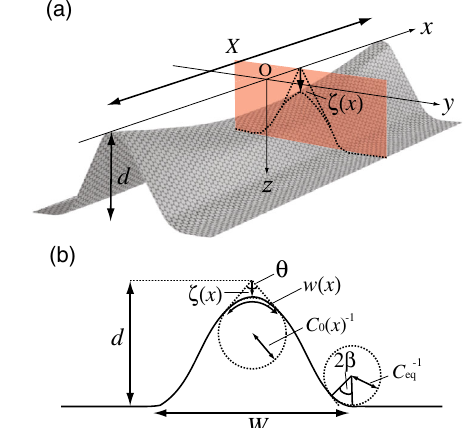
FIG. 2. Schematics of (a) a wrinkle formed between two nano- particles with diameters d and (b) the wrinkle profile along the transverse direction as represented by shaded area in